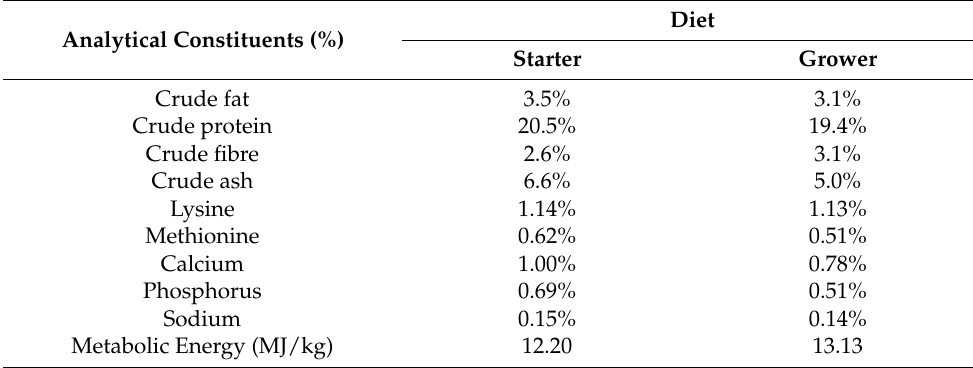
Table 1. Composition of starter and grower